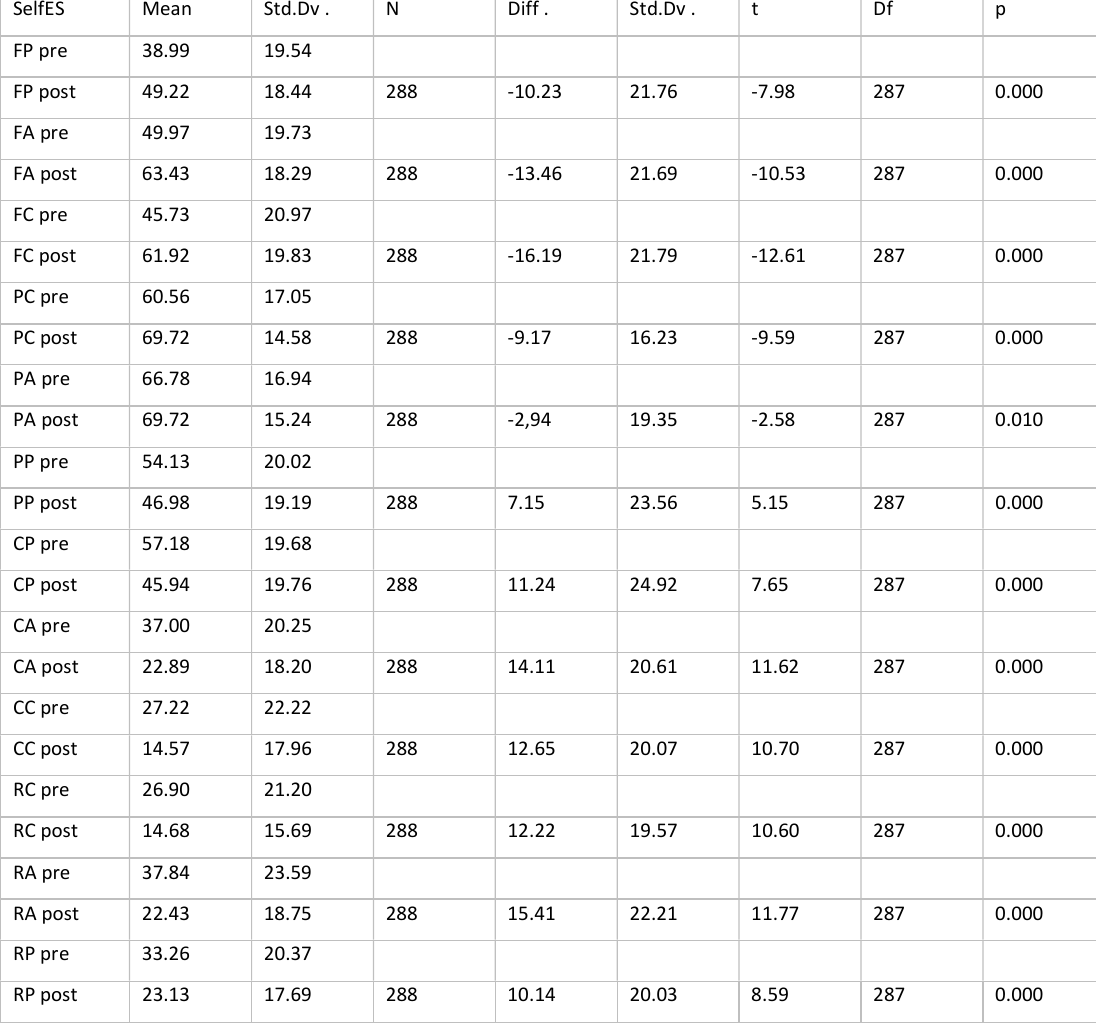
Table 1: means and standard deviation of 12 Self ES pre- and post-treatment, and Student T test